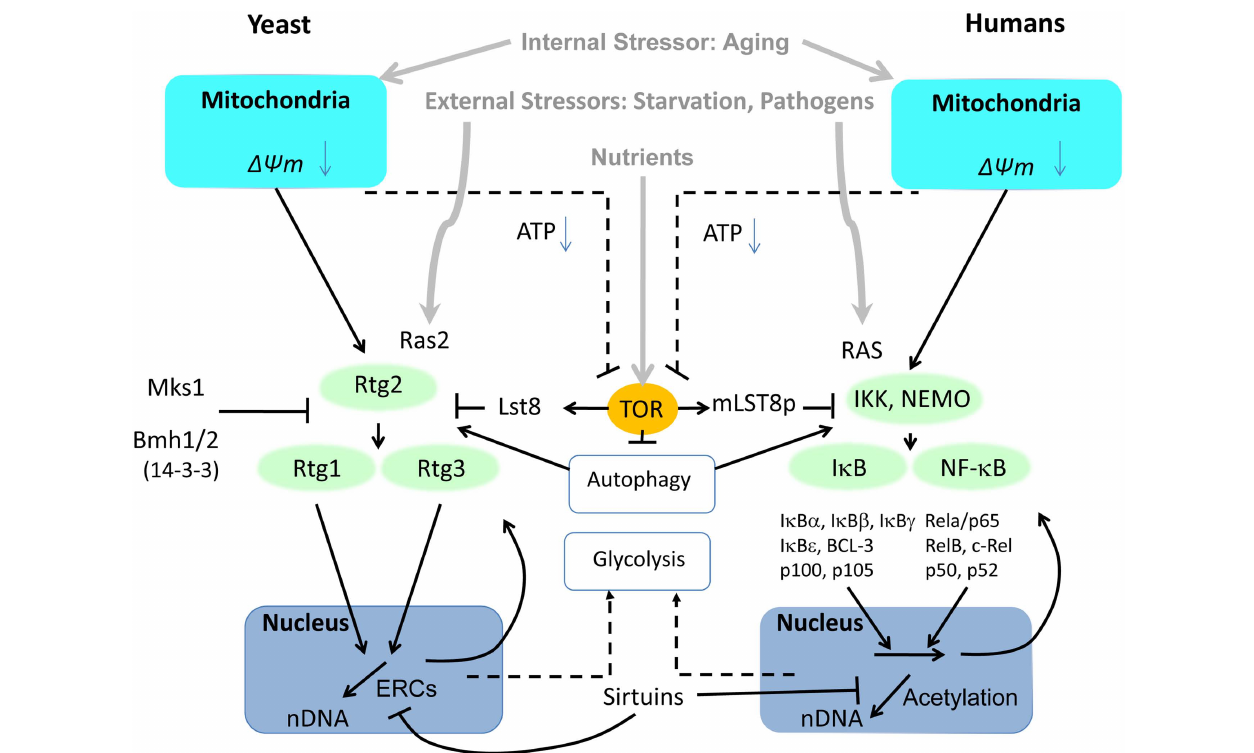
mitochondrial membrane potential ( ΔΨ m ). Another common activator that responds to external stressors is RAS (Ras2 in yeast). Furthermore, both pathways are modulated byTOR through LST8. LST8 dissociates from mTOR under stress, although it is not known whether this is true ofTOR in yeast. Regulation of autophagy byTOR impinges on both pathways, as well.The adaptive response of both pathways to mitochondrial dysfunction